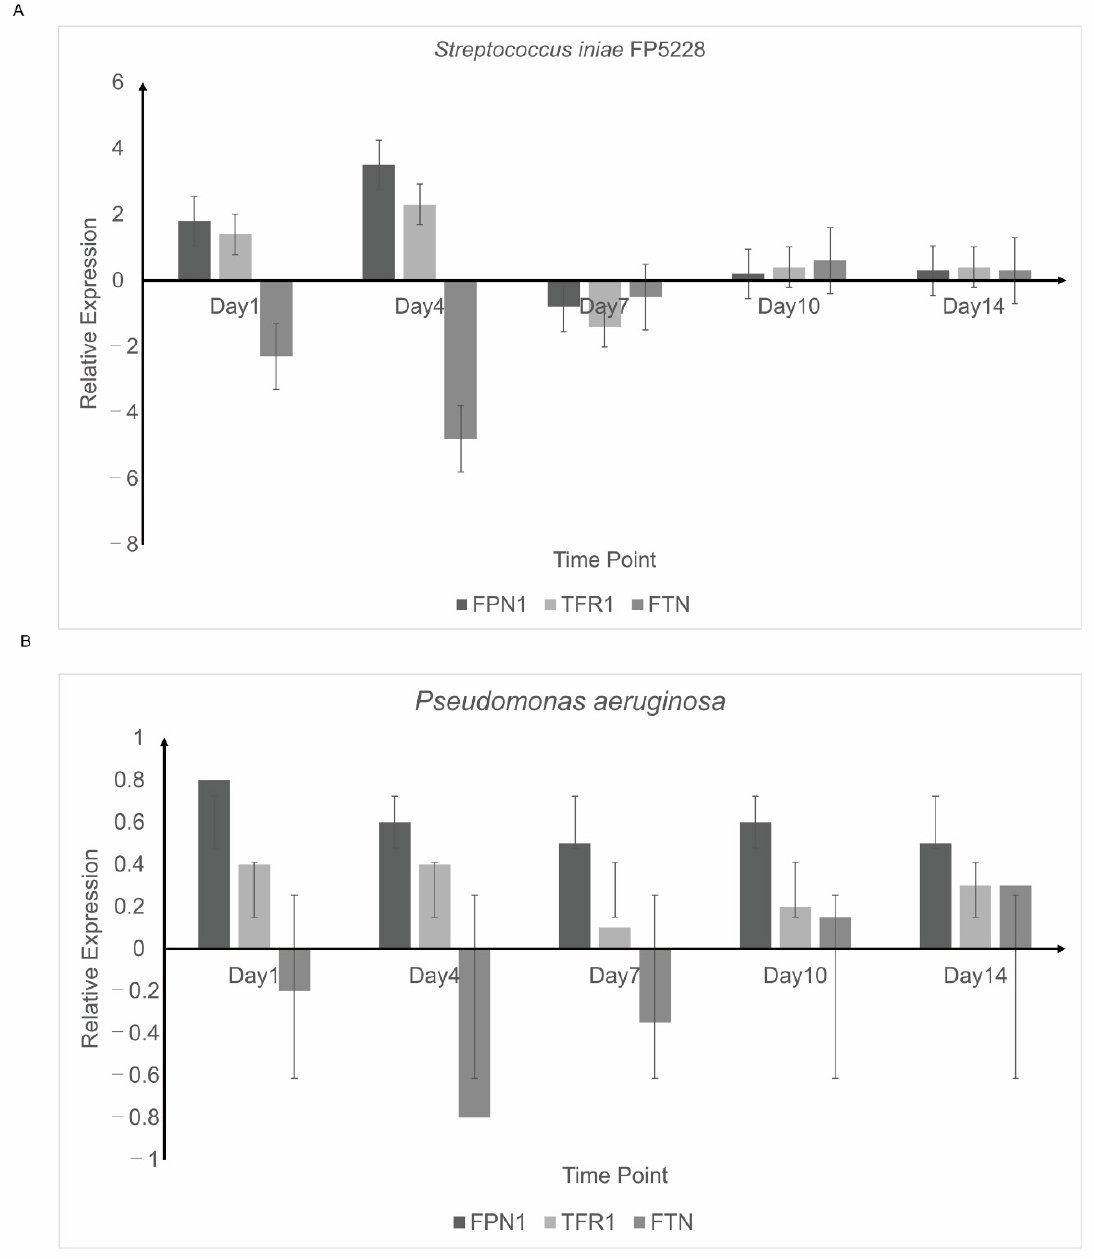
Figure 6. Hepcidin (Hamp1 and Hamp2) mRNA expression in the liver after bacterial infection ( A ) hepcidin (Hamp1 and Hamp2) mRNA expression in the liver after infection with Pseudomonas aeruginosa . ( B ) Hepcidin (Hamp1 and Hamp2) mRNA expression in the liver after infection with Streptococcus iniae FP5228.